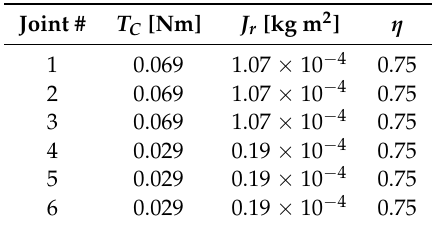
Table 4. Estimated reduction gears parameters: Coulomb friction torque, moment of inertia, average